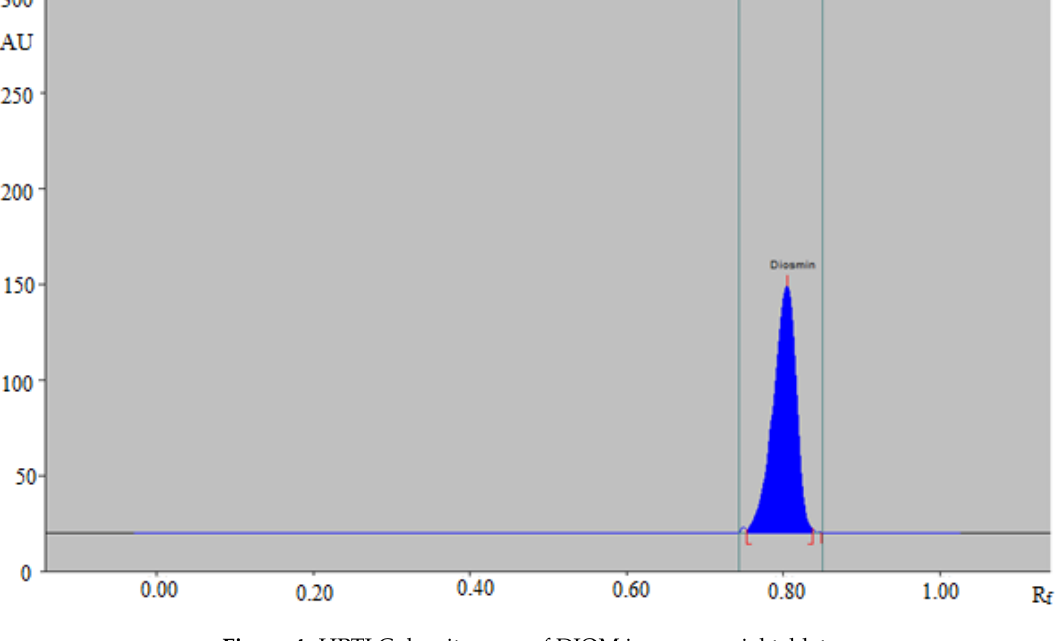
Figure 4. HPTLC densitogram of DIOM in commercial tablets.